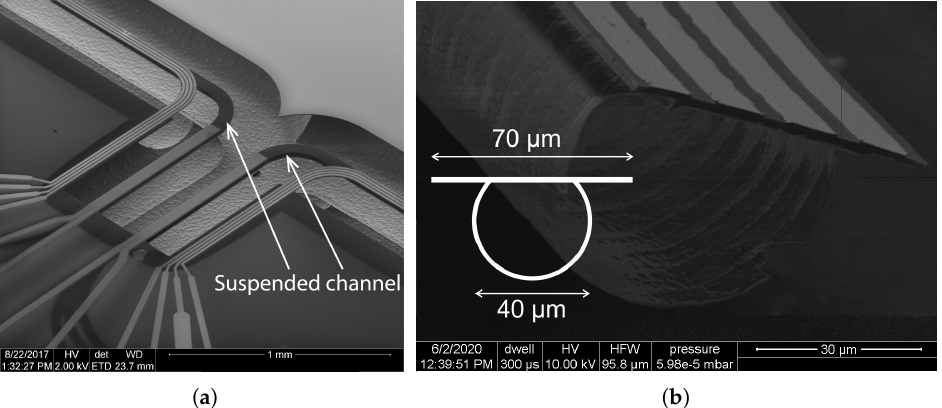
Figure 5. ( a ) SEM image of the suspended channel in a micro-Coriolis mass flow sensor, and ( b ) a cross sectional image of the channel with a schematic drawing showing the dimensions of the cross